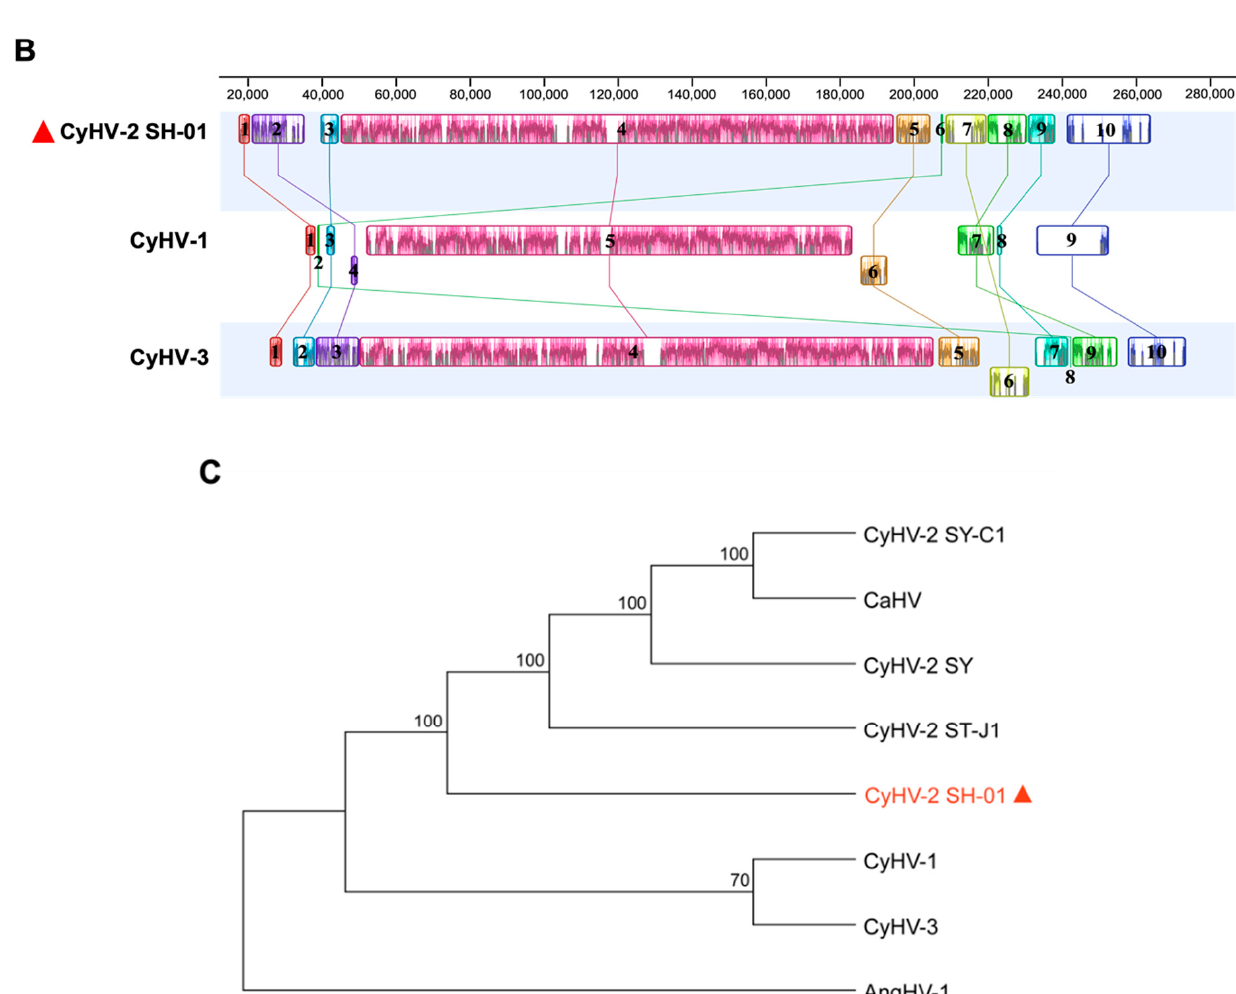
Figure 3. Genomic evolutionary relationships and phylogenetic analysis of SH-01 and the other seven strains. ( A ) Evolutionary patterns among the homologous or heterologous regions of the genomes of eight isolates, including SH-01, were analyzed by Mauve alignment in DNASTAR Lasergene v17.3. Different locally collinear blocks (LCBs) are marked with regions in different colors. Each genome was aligned by the LCB1 of SH-01, and homologous LCBs are connected by corresponding lines. Compared to SH-01, the large “jump” of ORF140 in CyHV-1 is marked in red. ( B ) Comparison of LCBs among SH-01, CyHV-1, and CyHV-3 using the progressive Mauve algorithm in Geneious Prime v2022.2.1. Different LCBs are marked with regions in different colors, and homologous LCBs are connected by corresponding lines. ( C ) Phylogenetic tree was constructed based on the amino acid sequences of helicase (ORF71) using the neighbor-joining method in MEGA v11 (https://megasoftware.net accessed on 10 July 2022). Bootstrap values of 1000 replications are shown at